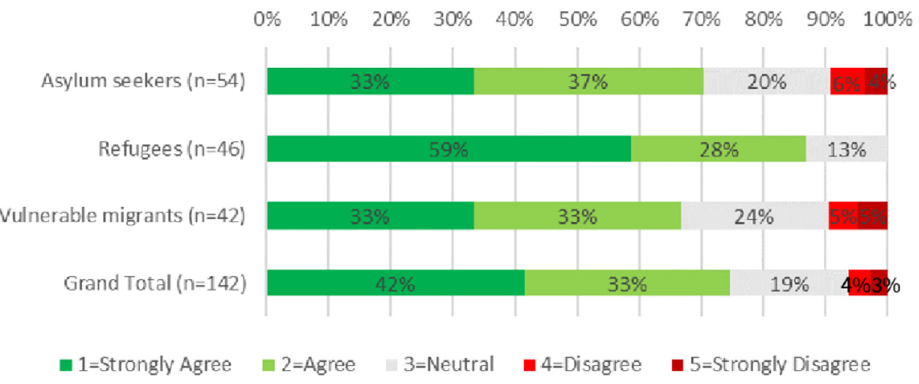
Figure 9. Considering my experience with the NADINE platform, I would recommend it to a friend or someone I know.